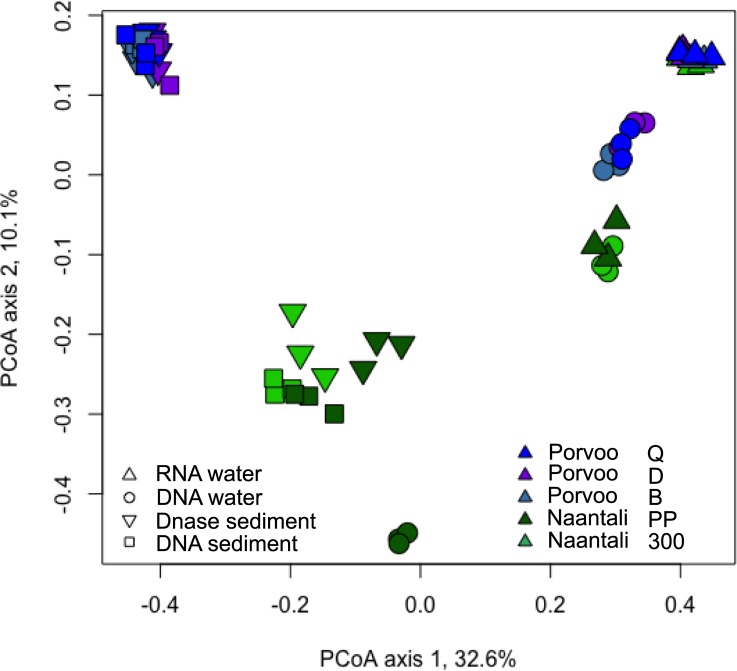
Principal coordinates analysis of fungal sequences from water and sediment samples.